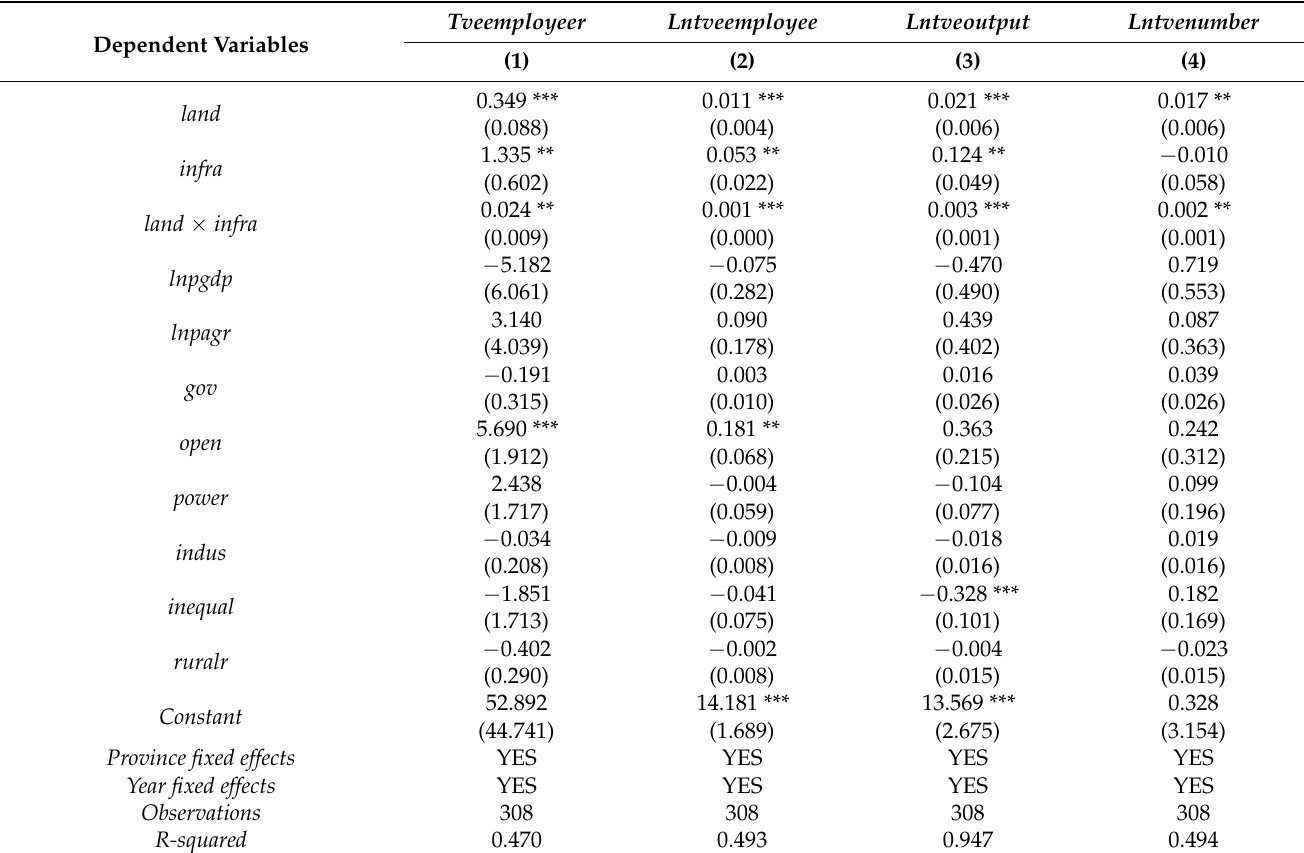
Table 5. Differential rent and regional heterogeneity of TVEs’